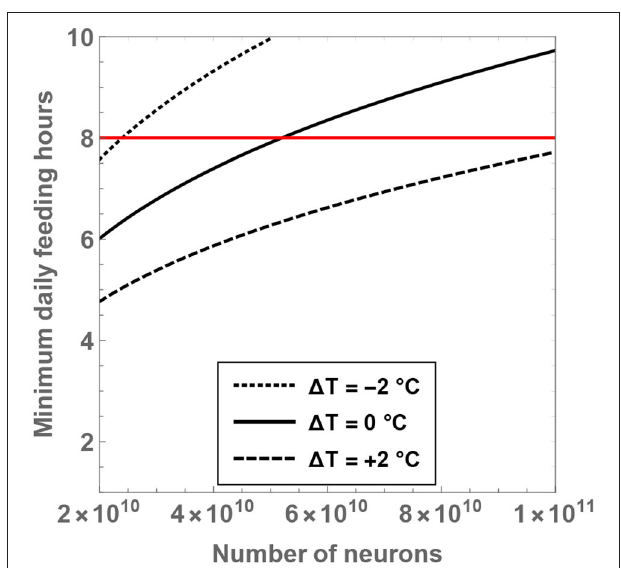
FIGURE 5 | The minimum number of daily feeding hours is shown as a function of the total number of neurons. The dotted, unbroken and dashed curves correspond to body temperatures that differ from present-day humans by − 2, 0, and + 2 ◦ C; the equivalent body temperatures are 35, 37, and 39 ◦ C, respectively. The horizontal red line depicts the “sustainable” upper bound on the feeding time per